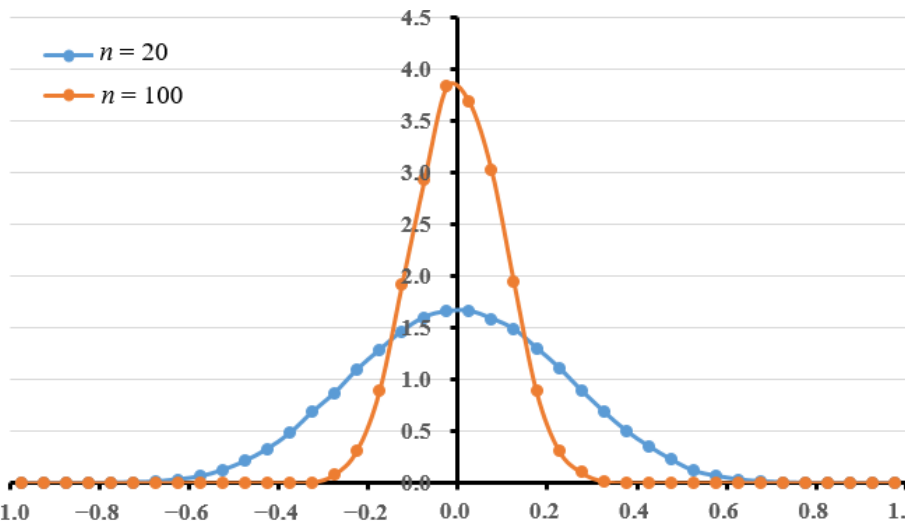
Figure 1. A comparison of the probability density distribution functions of zero-lag cross–correlations estimated from 10,000 normally distributed series of n = 20 and 100 length.